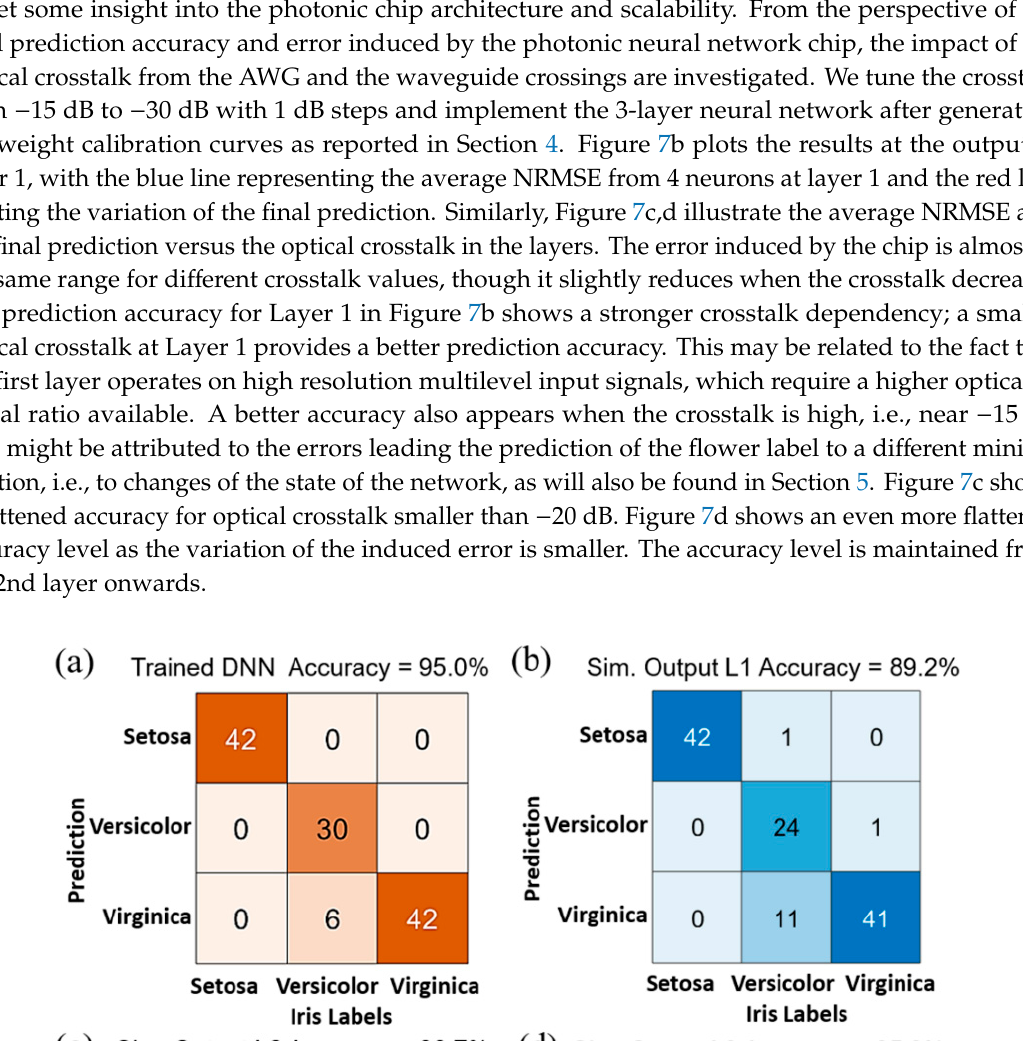
Figure 7. Error evolution: ( a ) Normalized root mean square error (NRMSE) versus the number of implemented photonic layers in simulation (solid line filled points) and experiment (dashed line open points), from single photonic layer (circles), the accumulation (triangles) and the corresponding prediction accuracy (squares). Crosstalk tuning: The induced error (blue circles) and the final prediction accuracy (red circles) versus the crosstalk from AWGs, recorded simulation results from ( b ) output of layer 1, ( c ) output of layer 2, and ( d ) output of layer 3.